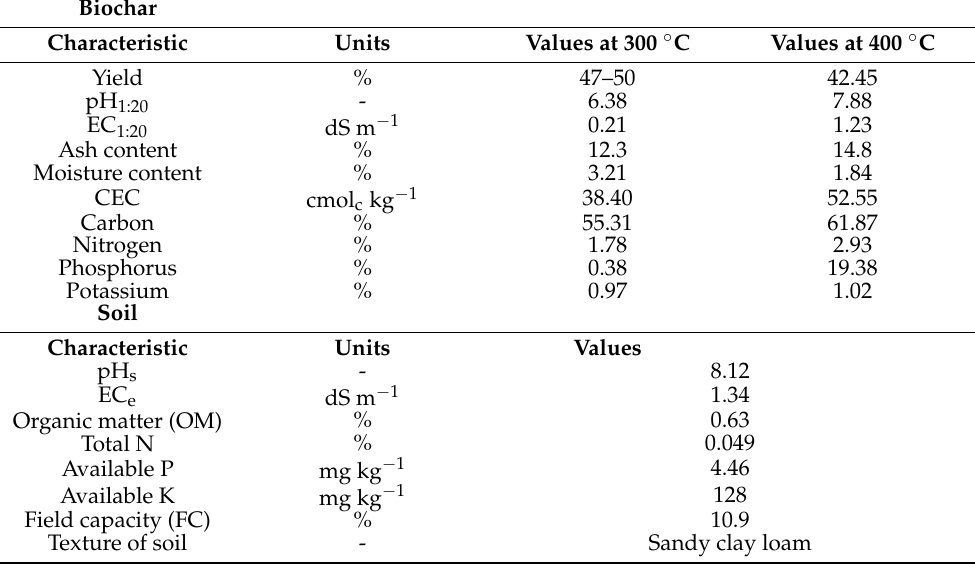
Table 1. Physicochemical properties of crushed corn cob biochar and soil.